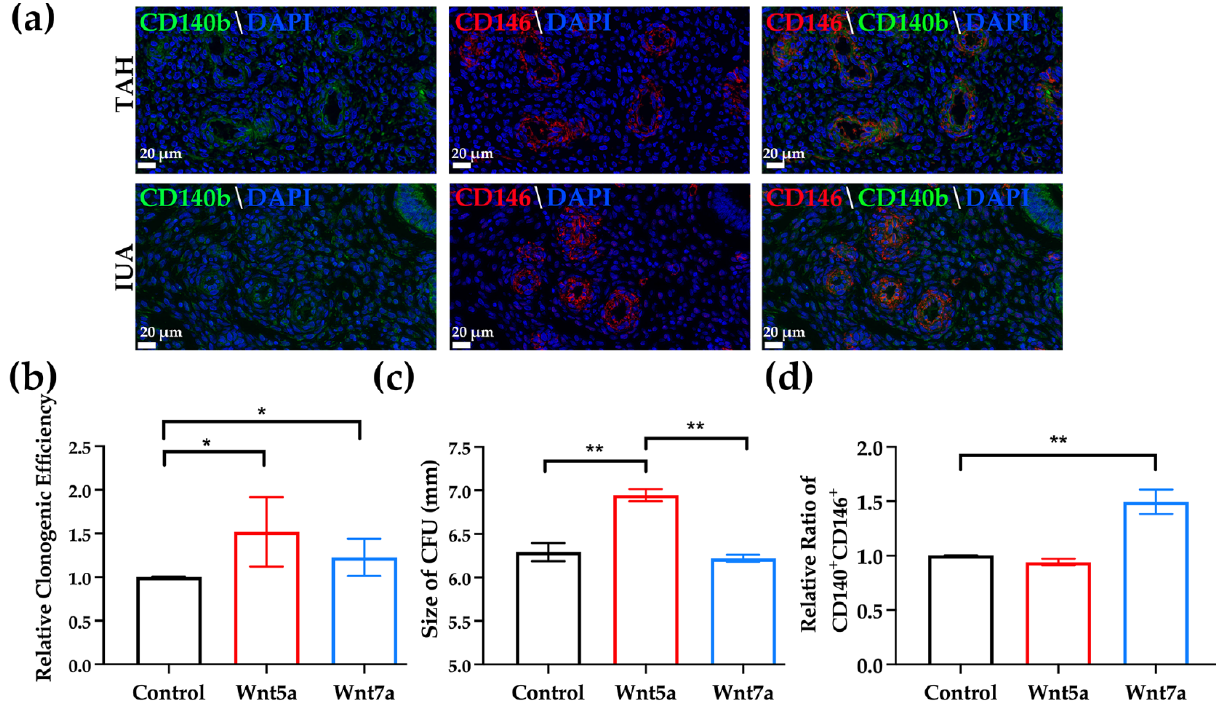
Figure 3. ( a ) Endometrial sections were stained with anti-CD140b (green), anti-CD146 (red) and DAPI (blue). CD140b and CD146 co-localization indicates population with enriched endometrial stem cells. The characteristics of CD140b + CD146 + population with supplemented recombinant Wnt5a or Wnt7a were examined. Scale bar, 20 μ m. Relative cloning efficiency ( b ), size of the CFUs ( c ) and relative ratio of the population with co-expression of CD140b and CD146 ( d ) were evaluated. Data are presented as mean ± SEM ( n = 5). * p < 0.05, ** p < 0.01.